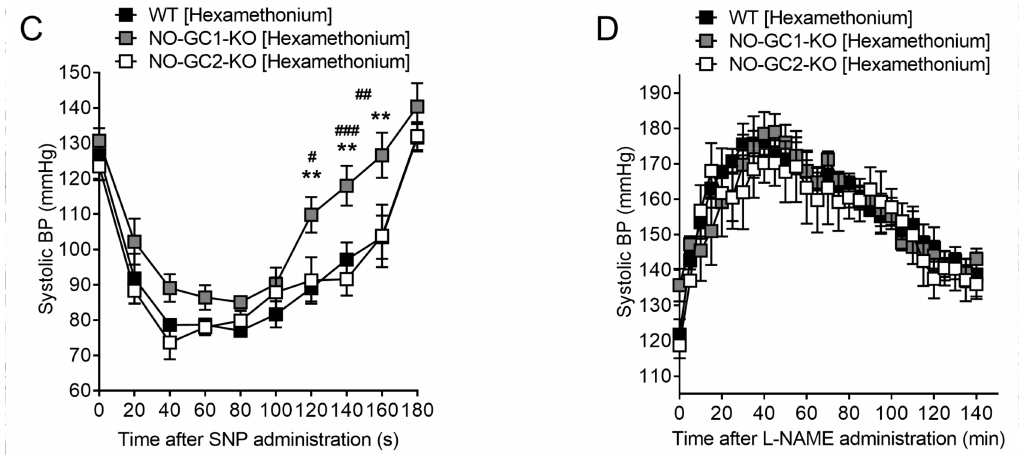
Figure 5. Predominant role of NO-GC1 in NO-mediated blood pressure changes in conscious mice. ( A ) Blood pressure reduction induced by the NO donor sodium nitroprusside (SNP) (30 µ g/kg BW) was significantly diminished in conscious NO-GC1-KO ( n = 4) mice compared to WT ( n = 4) and NO-GC2-KO ( n = 4) mice measured by radio telemetry; ( B ) Attenuated blood pressure increase by L-NAME (30 mg/kg BW) in NO-GC1-KO mice compared to WT and NO-GC2-KO mice; ( C , D ) Co-administration of hexamethonium (30 mg/kg BW) enhanced blood pressure reduction by GSNO and blood pressure increase by L-NAME in NO-GC1-KO ( n = 6) compared to WT ( n = 6) and NO-GC2-KO ( n = 6) mice. * p < 0.05, ** p < 0.01, *** p < 0.001 vs. WT; # p < 0.05, ## p < 0.01, ### p <